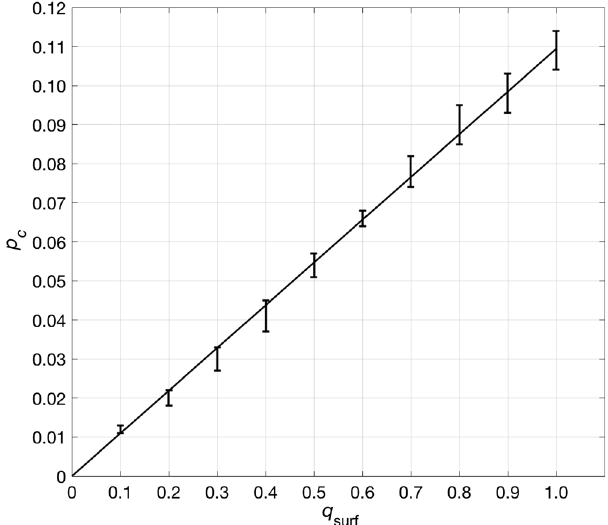
FIG. 5. Scaling of the critical disorder p with respect to the c surface density q . Autocorrelation is checked using a binning surf analysis; the fit is linear through the origin. The widest error bars 1 , the results are of total width of approximately 1%. At q surf ¼ 0 . 1094 (cid:3) closely match the established critical point at p c ¼ 0 . 0002